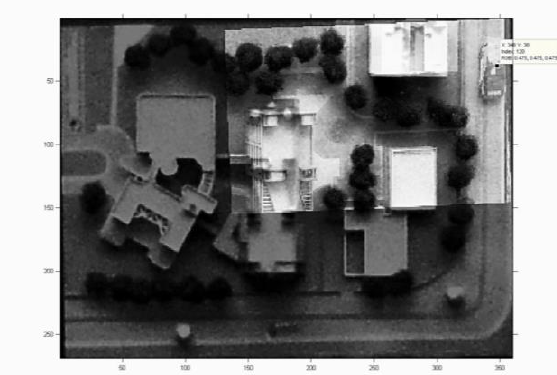
Figure 11. Target Geolocation during experimental setup with reference to its rows and column of its reference frame. The mobile camera image is shown overlaid on Nikon image after registration.